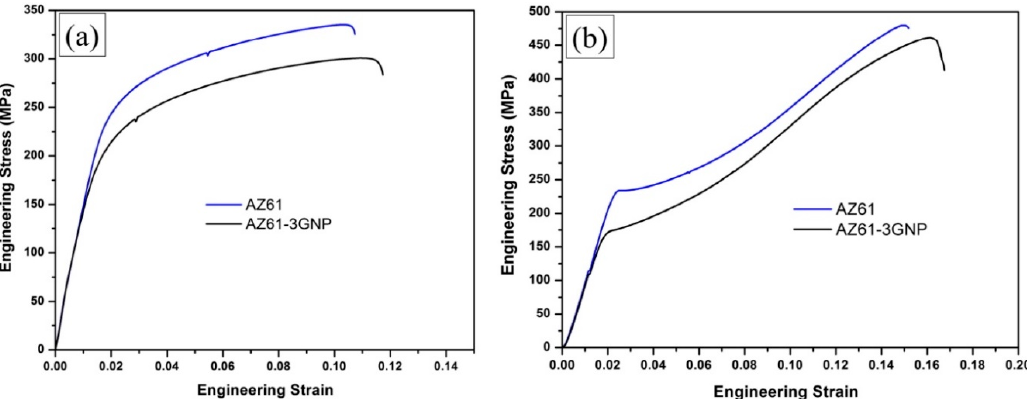
Figure 15. ( a ) Tensile, ( b ) compression stress–strain curves of AZ61 alloy and its nanocomposite at room temperature [183] (Copyright Elsevier, 2016, Materials & Design).